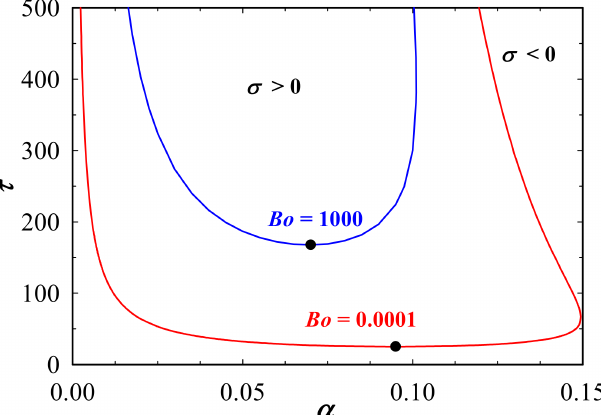
Figure 4. Neutral stability (solid lines) curves for the capillary-dominant ( Bo = 0.0001) and the buoyan cy-dominant ( Bo = 1000) systems obtained by solving Equation (28) at σ = 0. The dots show the wavenumbers that minimize σ , i.e., critical points. The other parameters are fixed: M = 0.1 and G =